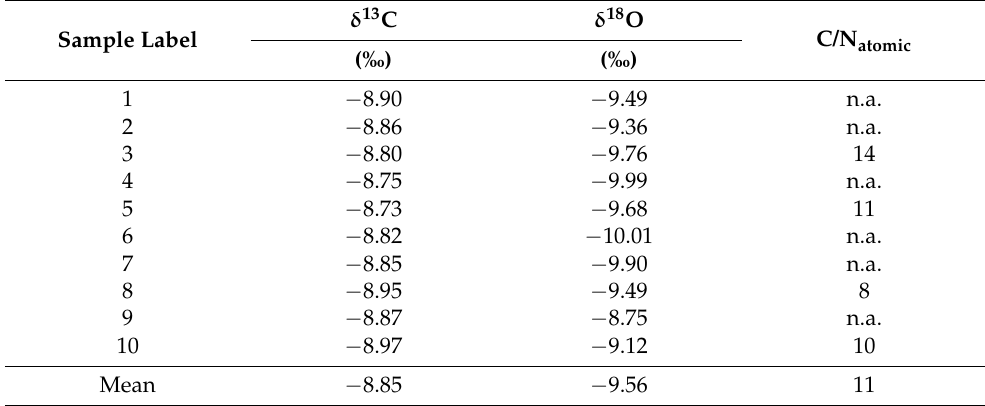
Table A2. Stable isotope composition (‰) (uncertainty 0.05‰) and atomic C/N ratio for each analyzed layer.